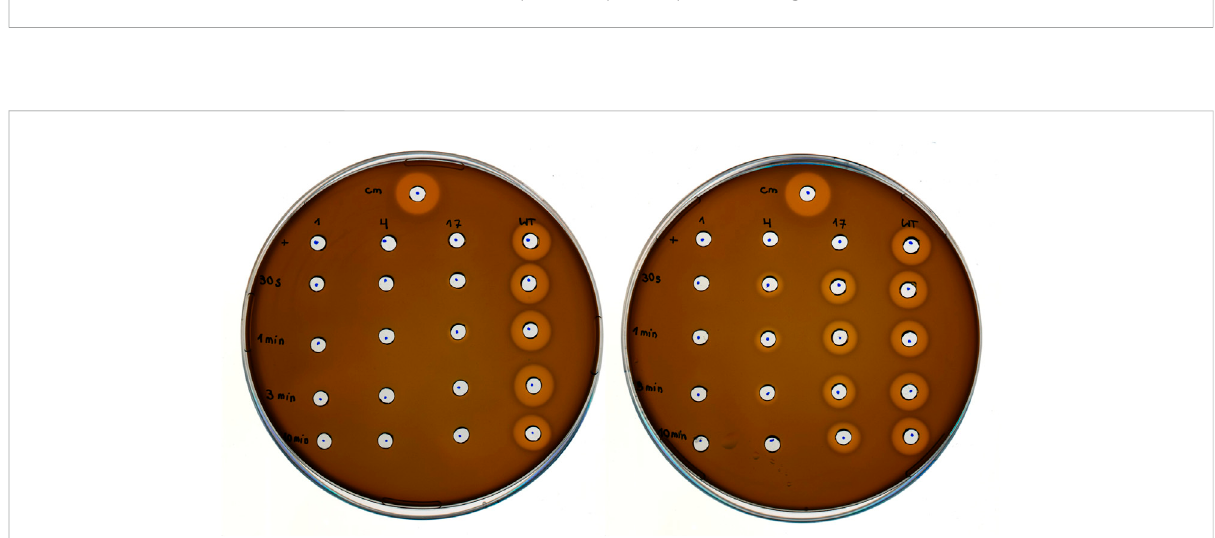
FIGURE 10 Antimicrobial activity of photocaged and decaged (UV-irradiated) nisin derivatives. L. lactis indicator strain assay using E. coli cell lysates containing nisin modi fi ed with ONBY (3) at position I1, I4 and M17, respectively, with recombinant wild-type nisin (WT) as reference. E. coli lysates were prepared with either B-95. Δ A (progenitor, left) or B-95. Δ A NK53 (nitroreductase knockout, right) as host strain. Cm = Chloramphenicol